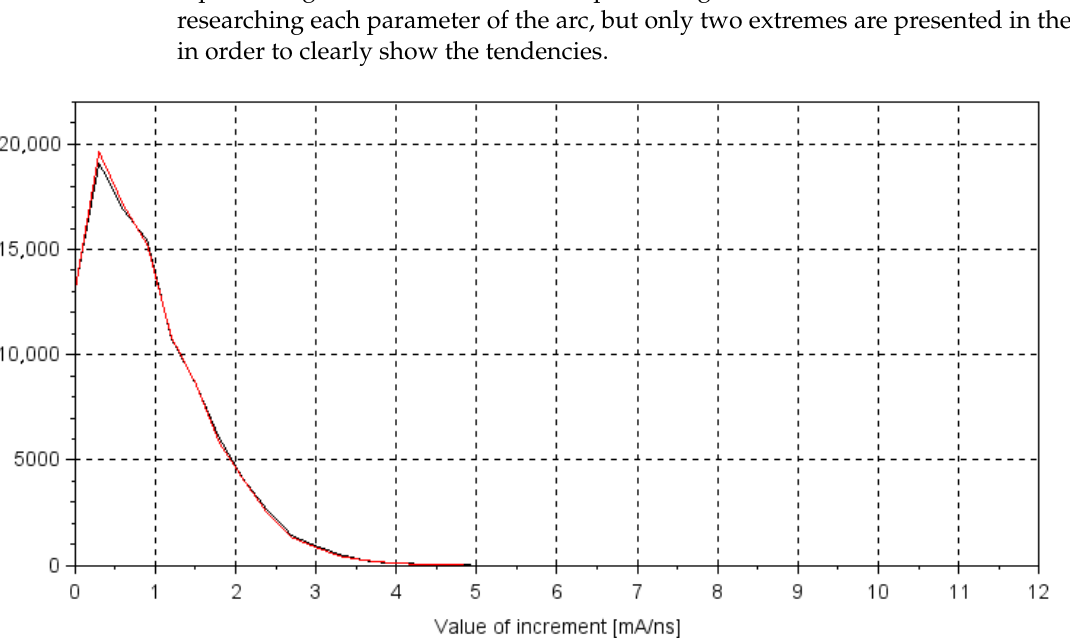
Figure 8. Figure showing 100 kpts decompositions of signals at different voltages, with 160 V (black) and 1.6 kV (red) (conditions: 1 mm gap between electrodes and current of 900 mA DC at each measurement). Figure 9. Figure showing 100 kpts decompositions of signals at different loads, with 700 Ω (black) and 1.6 kΩ (red) (conditions: 1 mm gap between electrodes and voltage of 800 V DC at each meas- urement).